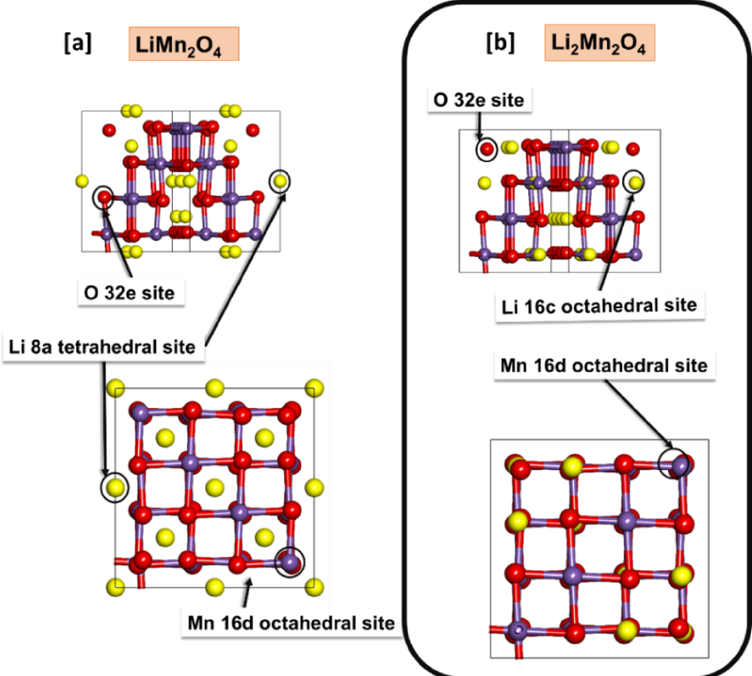
Figure 1. Conventional unit cells of ( a ) cubic LiMn 2 O 4 and ( b ) cubic Li 2 Mn 2 O 4 depicting the Wyckoff positions of lithium (yellow), manganese (purple) and oxygen (red) atoms in 8a or 16c, 16d and 32e sites, respectively.